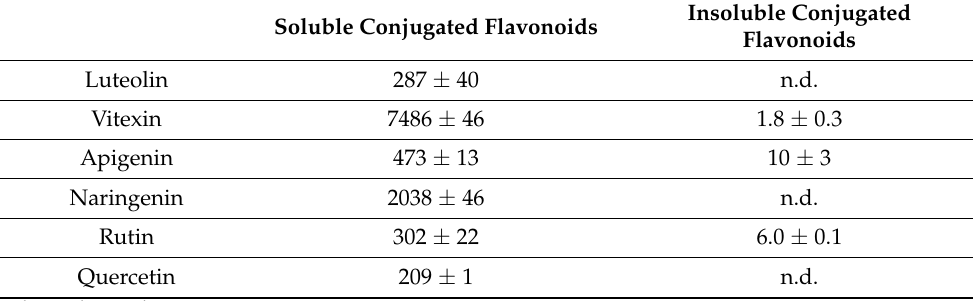
Table 3. Soluble and insoluble flavonoids ( µ g g − 1 ) in Camelina sativa defatted seed meal (DSM). Average values ± standard deviations ( n = 3) are